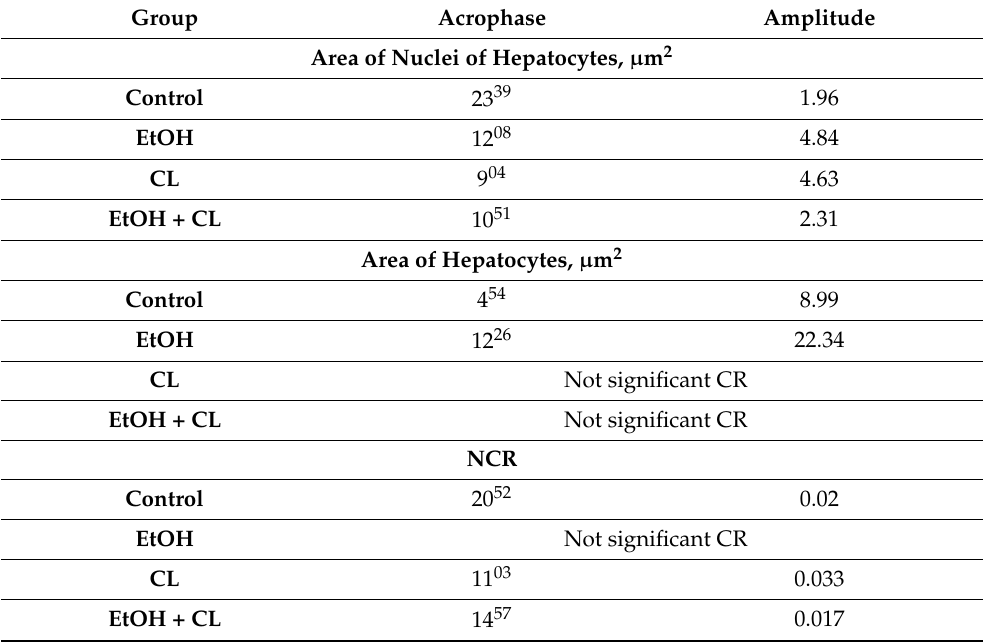
Figure 14. Daily dynamics of hepatocyte area of rats.